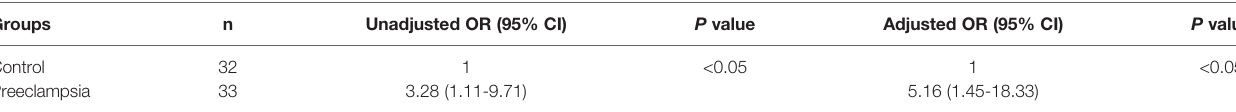
TABLE 3 | The unadjusted and adjusted ORs with 95% CIs of the relationship between preeclampsia and BMI. Groups n Unadjusted OR (95%